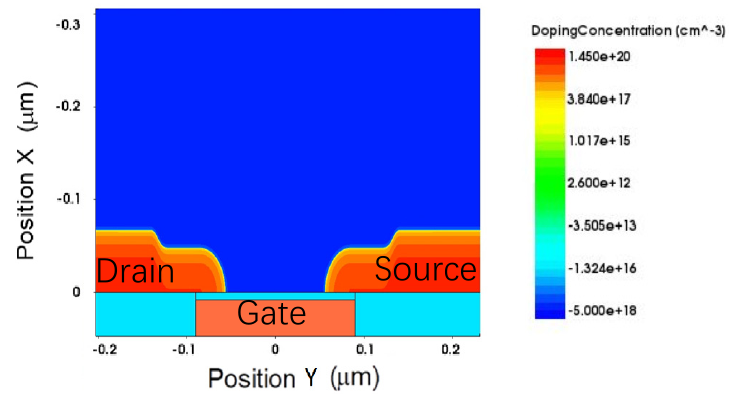
Figure 1. The doping distribution in the device structure used in the simulations. The simulation program does not report the actual doping in the gate and in the oxide, treated as ideal.